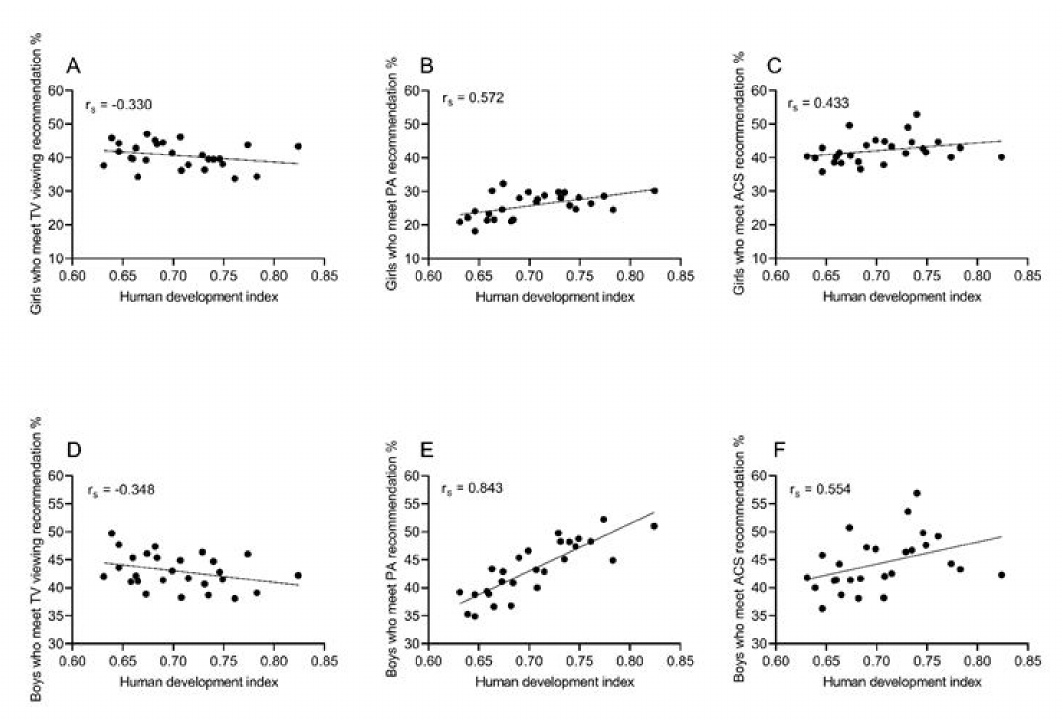
Figure 2 - Correlation between Human Development Index and meeting guidelines for TV viewing among girls (A) and boys (D), PA among girls (B) and boys (E), and ACS among girls (C) and boys (F) in Brazilian students. PA: physical activity. ACS: active commuting to